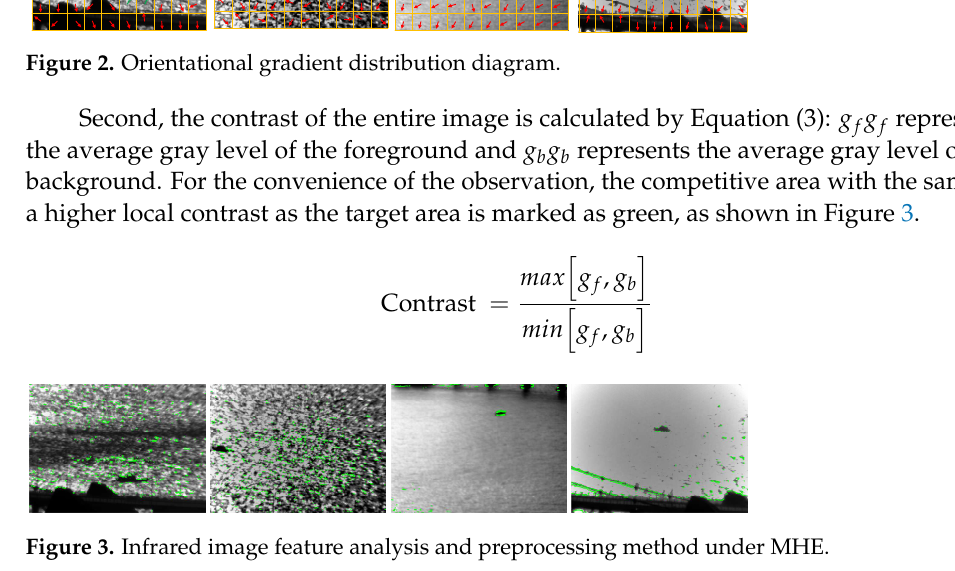
Figure 3. Infrared image feature analysis and preprocessing method under MHE.